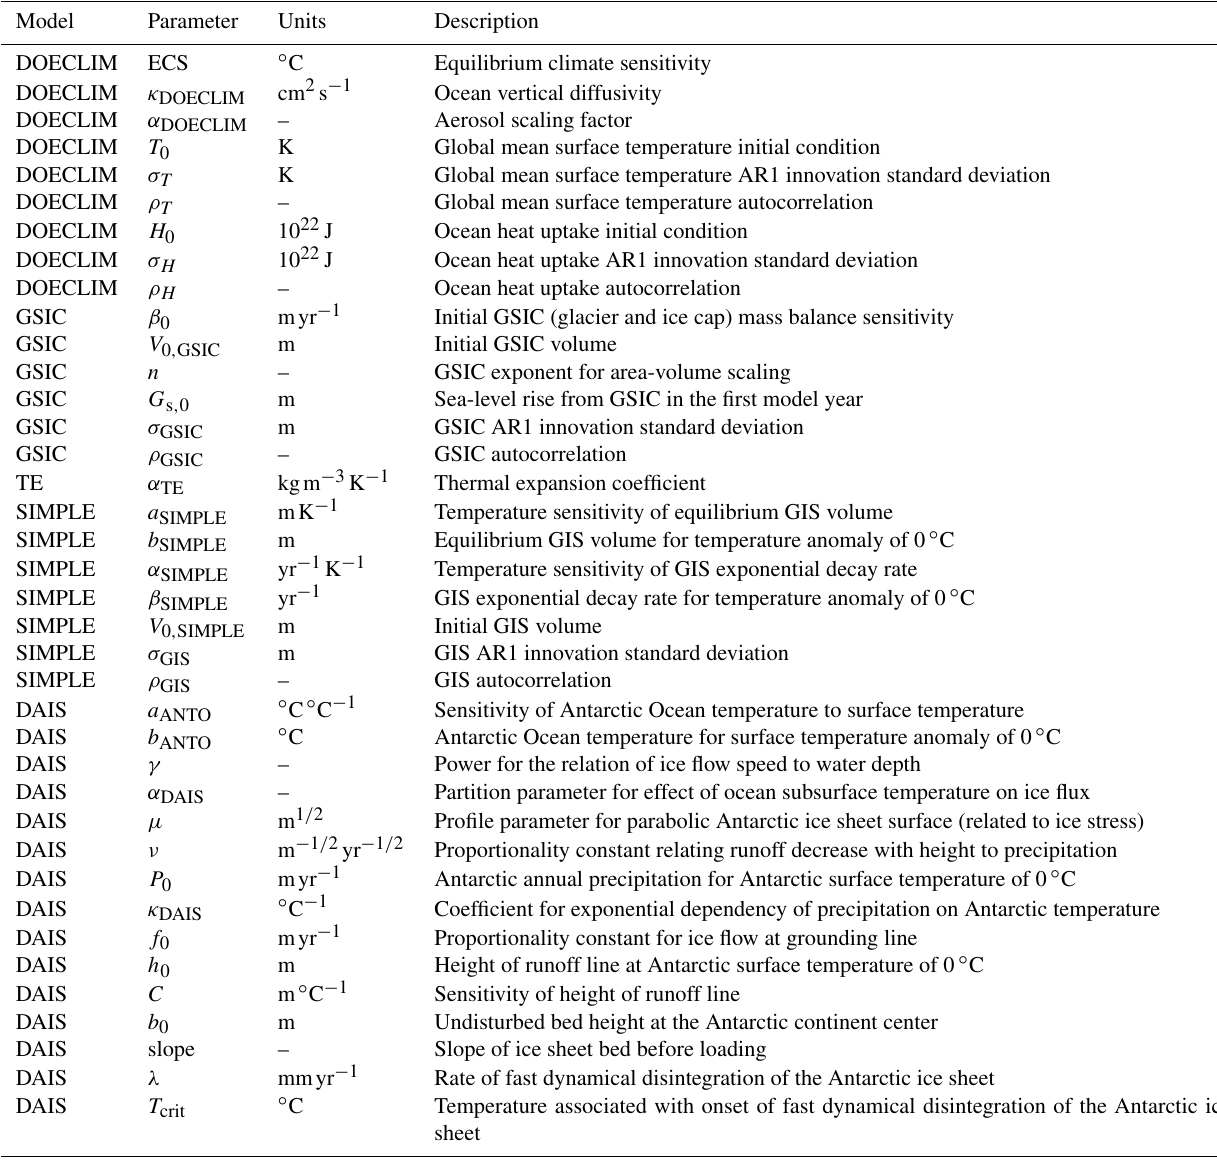
Table A1. Hector–BRICK model parameter names, units, and descriptions (Vega-Westhoff et al., 2019).